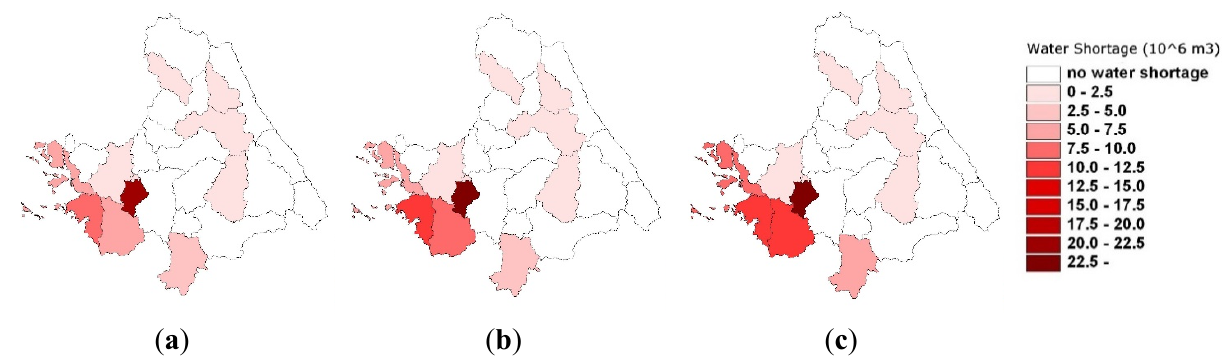
Figure 8. Average water shortage in each sub-watershed of the Han River basin (unit: 10 6 m 3 /year) ( a ) 2020s; ( b ) 2050s; ( c )